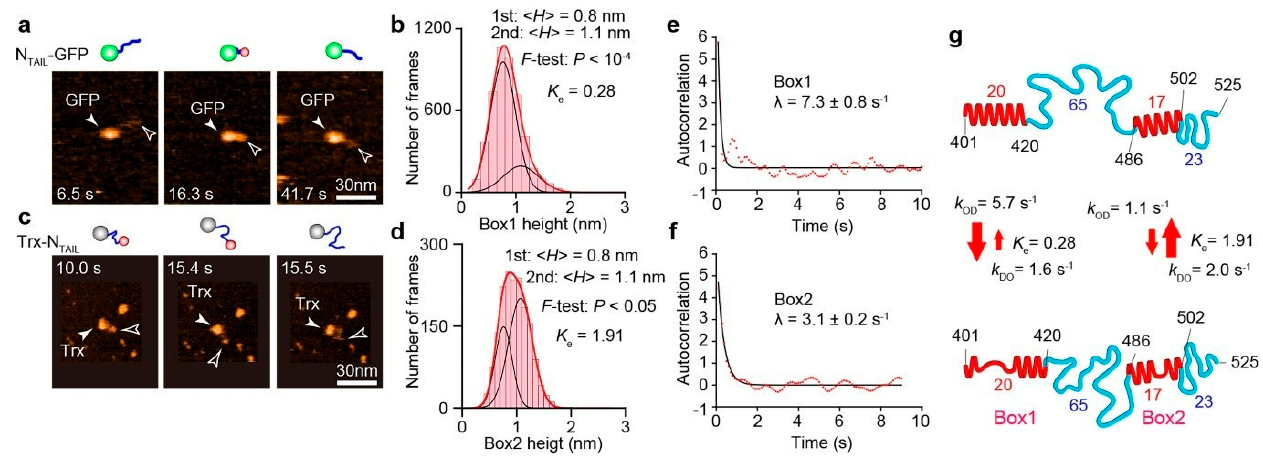
Figure 5. HS-AFM analysis of structure and dynamics of N TAIL . ( a ) HS-AFM images and their schematics of N TAIL -GFP. The open arrowheads point to the N-terminal end of N TAIL . ( b ) Height distribution of the N-terminal globule (i.e., Box1). ( c ) HS-AFM images and their schematics of Trx-N TAIL . The open arrowheads point to the C-terminal globule of N TAIL . ( d ) Height distribution of the C- terminal globule (i.e., Box2). ( e, f ) Autocorrelation functions of time-series height data of Box1 ( e ) and Box2 ( f ). The values of λ represent the respective decay constants of the autocorrelation functions. ( g ) Schematics showing structural and dynamic features of N TAIL . The top and bottom panels correspond to the more- and less-ordered states, respectively. The red arrows indicate the kinetic nature of changes in height of Box1 and Box2.